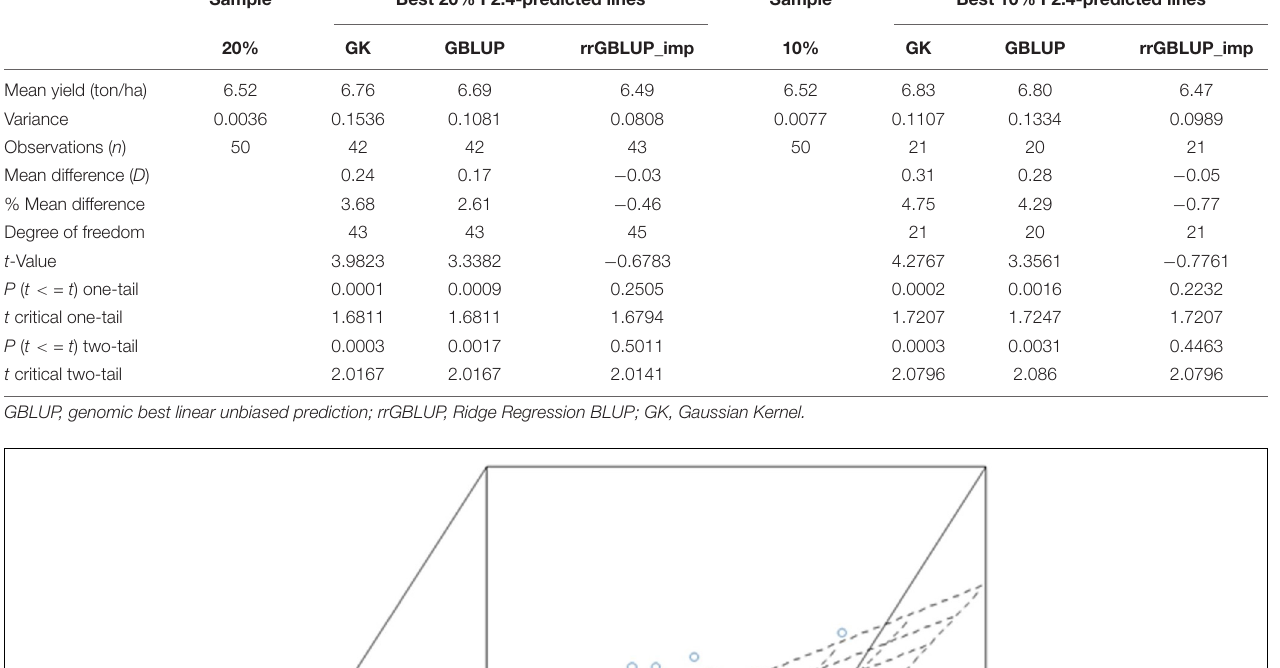
TABLE 7 | Yield of F2:4 lines based on selection of the top 10 and 20% of GEBVs from different methods (GBLUP, GK, and rrGBLUP_imp) compared to a random sample of 10 and 20% of all F2:4 lines, with 50 × sampling (the top 10 and 20% t -test: Two-Sample Assuming Unequal Variances. Sample